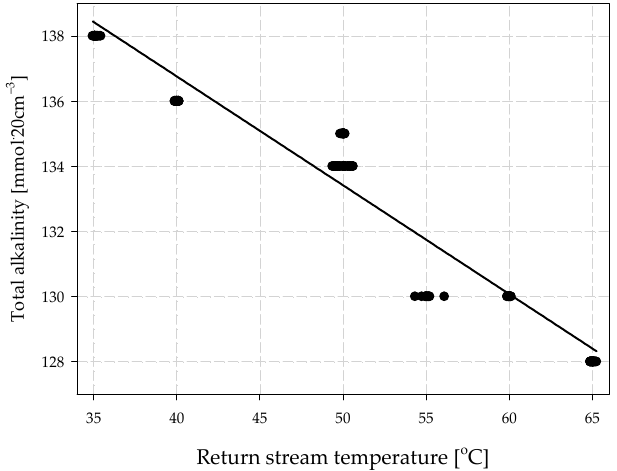
Figure 2. Effect of return stream temperature on total alkalinity of AAB.